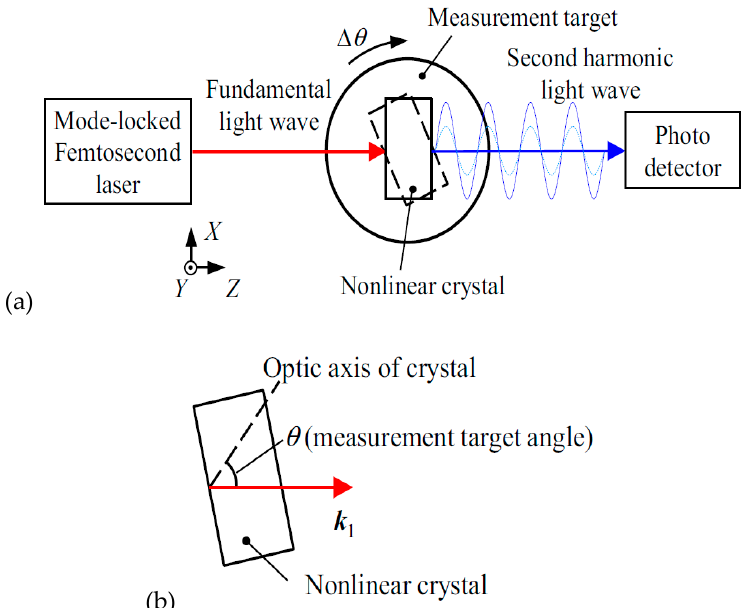
Figure 17. Measurement of the angular displacement of an object based on the characteristics of the matching angle in the second harmonic generation (SHG) [59]: ( a ) Schematic of the optical setup; ( b ) The angle to be measured by the method. Appl. Sci. 2020 , 10 , x FOR PEER REVIEW